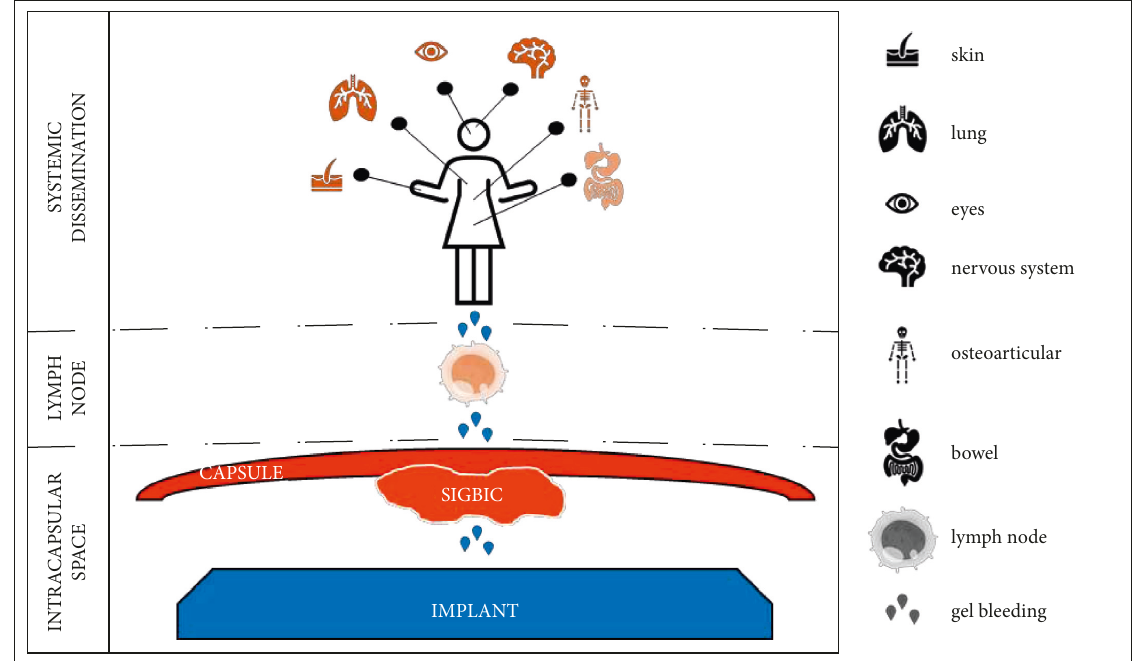
Figure 2: Example of silicone gel bleeding. The silicone will form the granuloma. As the implant is a continuous silicone generator, the silicone corpuscles can reach the pericapsular space. After going to the pericapsular space, silicone can reach the sentinel lymph node and later reach distant